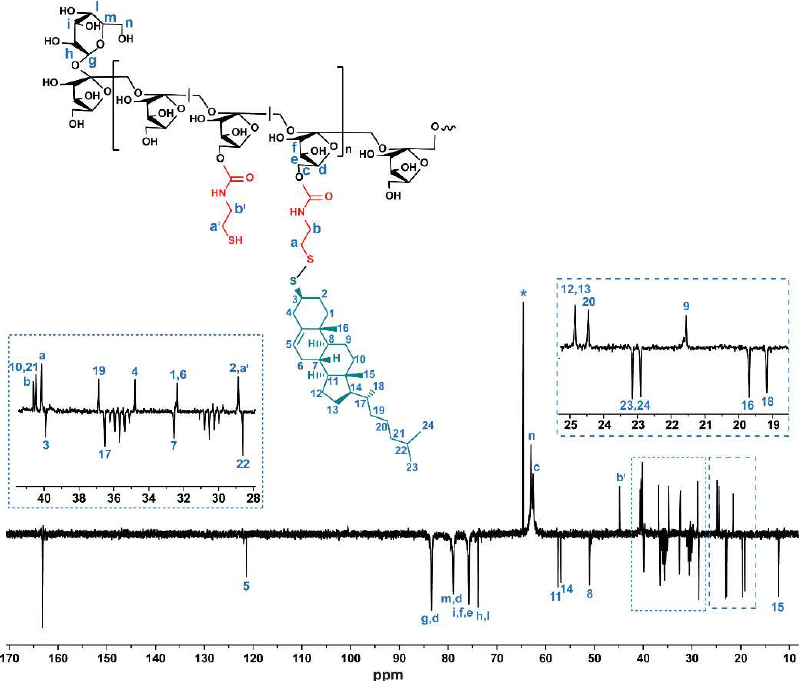
Figure 3. DEPT 13 C-NMR of INU-Cys-TC (DMF-d 7 , 300 MHz). The structure and relative chemical shift assignments are reported as insertions.